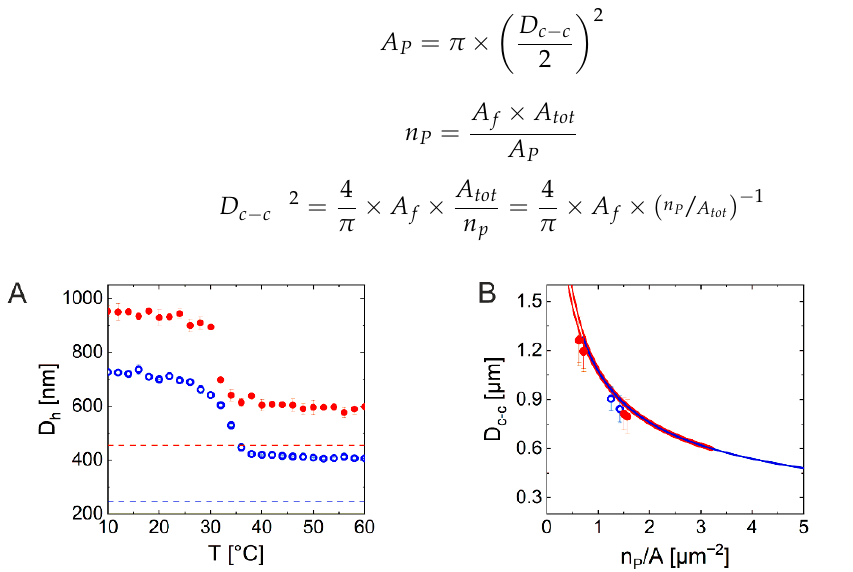
Figure 4. ( A ) Evolution of the hydrodynamic diameter ( D h ) for C 245 S 2.9 (blue) and C 455 S 2.3 (red) as a function of temperature. The dashed, horizontal lines correspond to the respective core diameters measured by TEM. ( B ) Calculated interparticle distance ( D c-c ) against the number of particles per unit area (n P / A ) for 2D compression accounting for an area fraction of 0.91 (solid lines, blue: C 245 S 2.9 , red: C 455 S 2.3 ). Symbols with error bars: measured data at three different surface pressure (10, 20, and 30 mN/m, blue: C 245 S 2.9 , red: C 455 S 2.3 ).